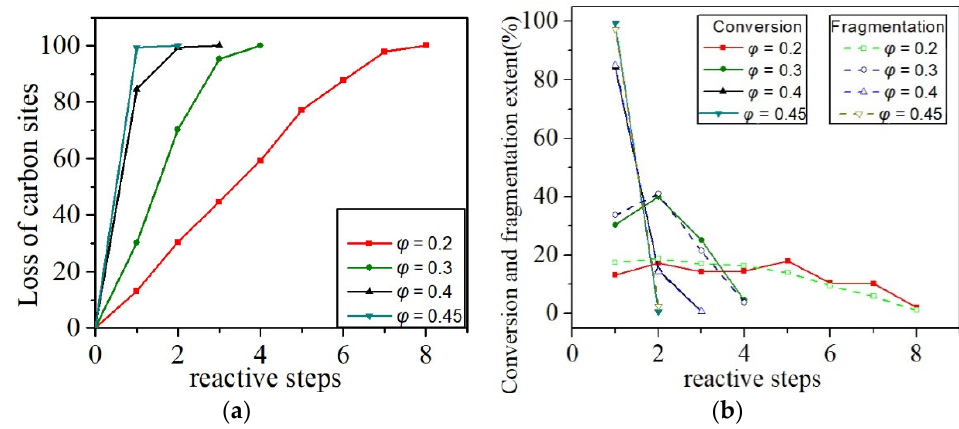
Figure 6. Char conversion: ( a ) The loss of carbon sites increases with reactive steps; ( b ) Char conversion and the extent of fragmentation.